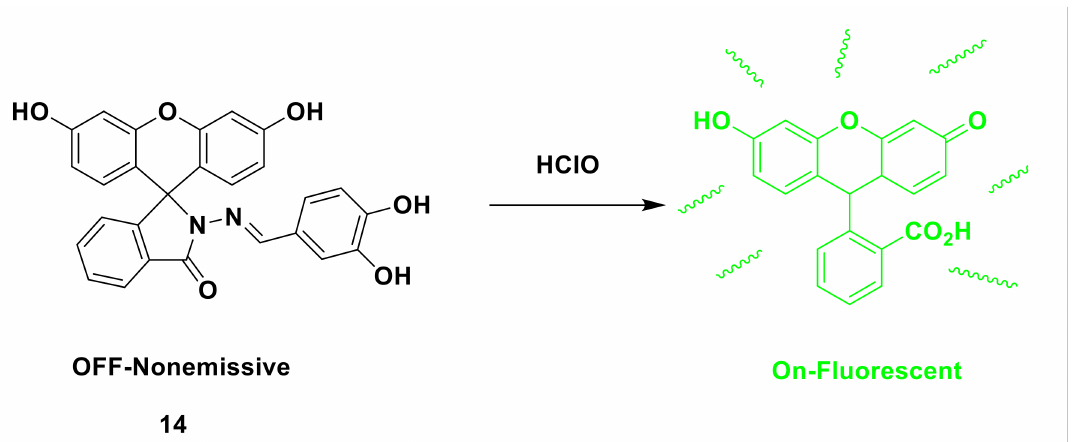
Figure 16. The reaction of probe 14 and HClO.